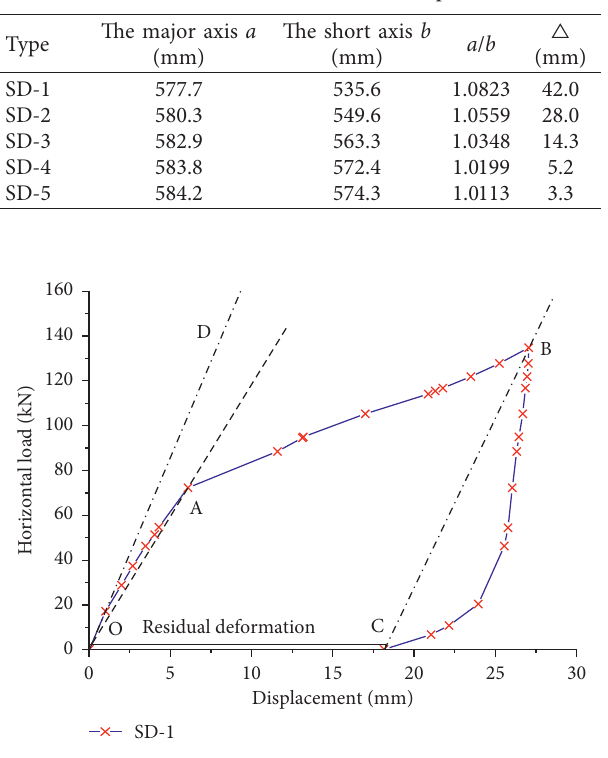
Figure 17: The load-displacement curve of elastic-plastic